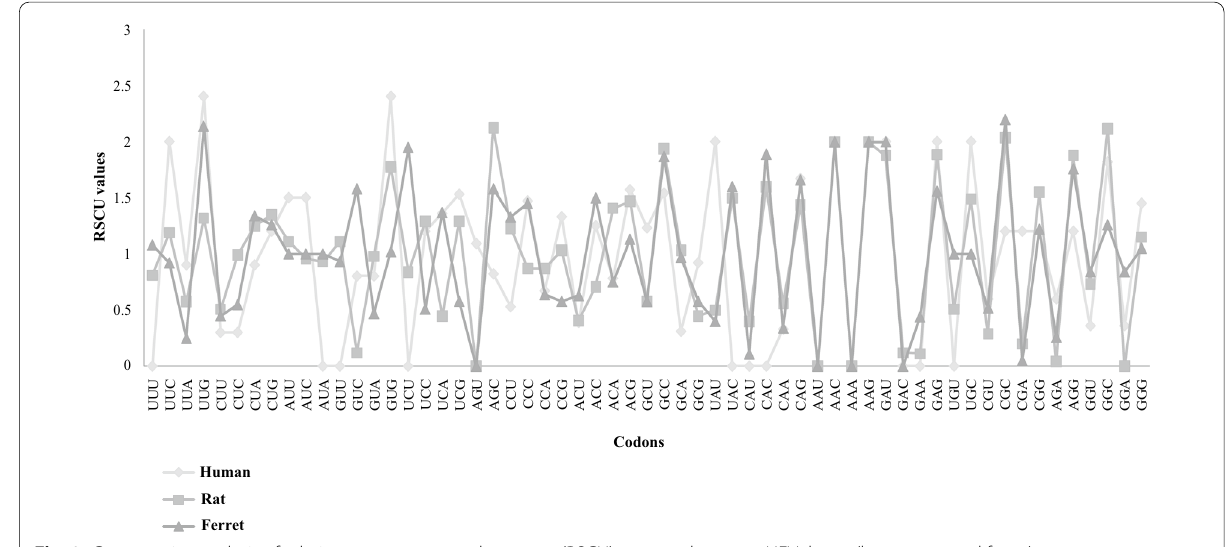
Fig. 2 Comparative analysis of relative synonymous codon usage (RSCU) patterns between HEV- hosts (human, rat and